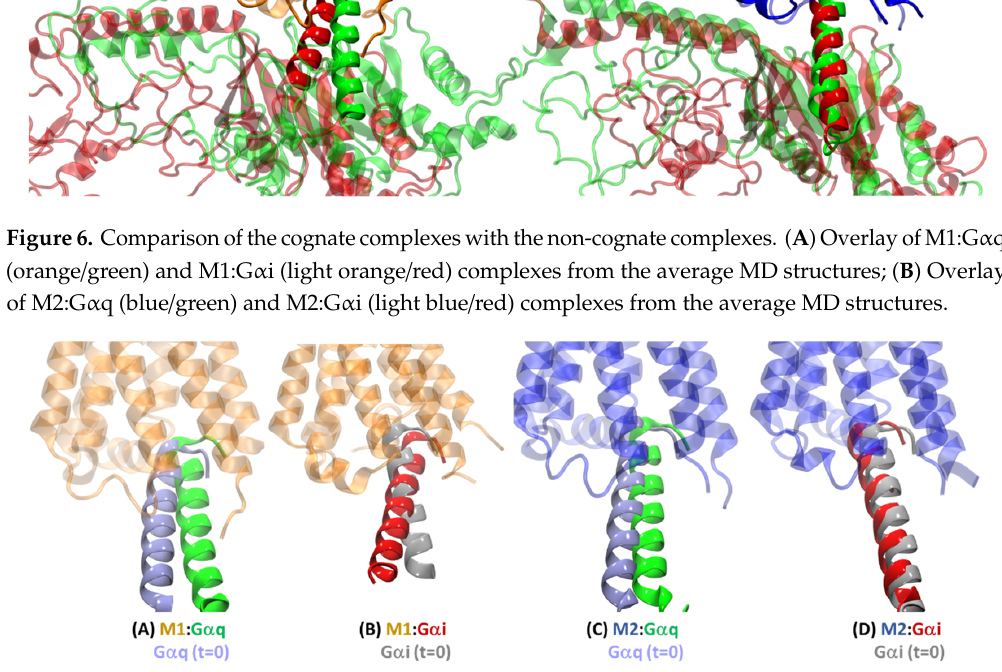
Figure 7. Comparison of α 5 helix orientation in the average structures after MD for: ( A ) M1:G α q, ( B ) M1:G α i, ( C ) M2:G α q, and ( D ) M2:G α i, with those shown in grey at the beginning of those simulations (i.e., at t = 0). The rest of the G α protein is hidden for clarity in all